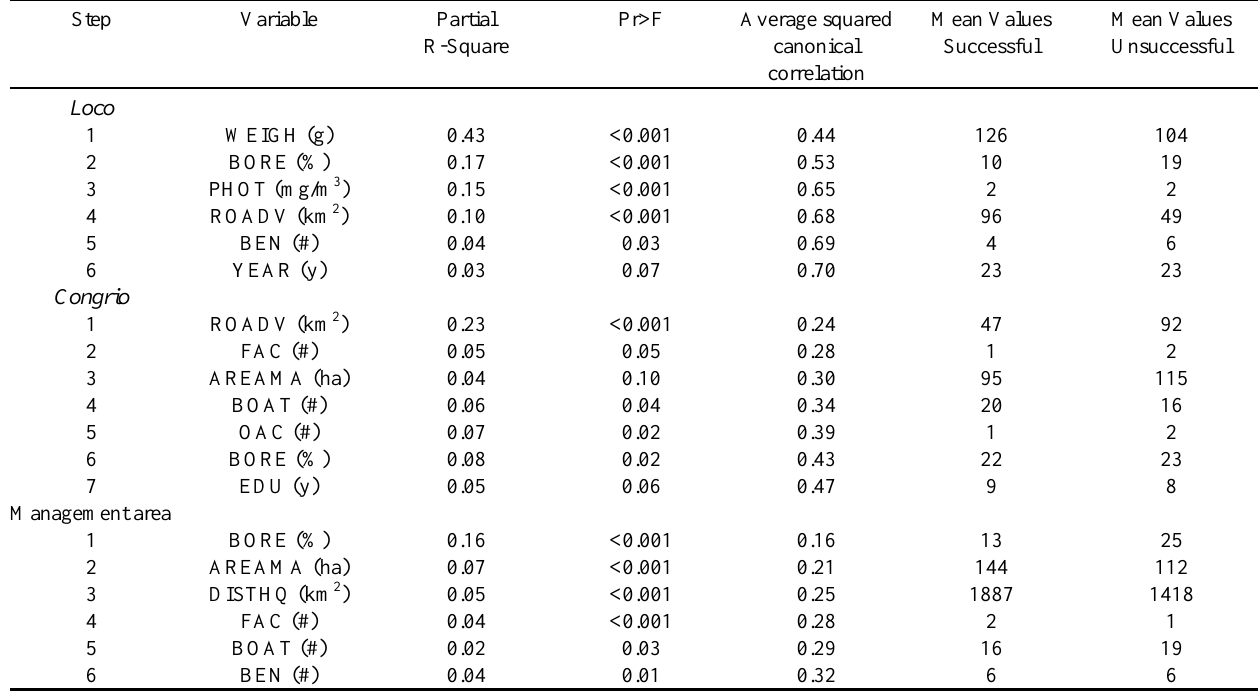
Table 6 . Partial r-square, significance levels, and average squared canonical correlation of stepwise discriminant analysis of loco characteristics. Successful and unsuccessful fisher groups were split using median values. In the discriminant analysis, independent variables entered and remained in the model if p-value £